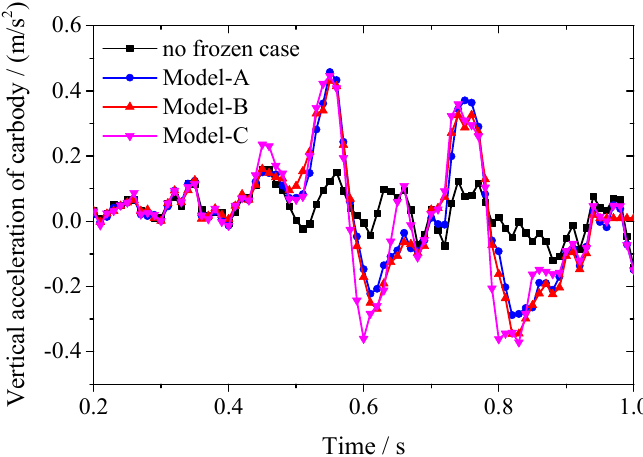
Figure 15. Time history of vertical acceleration of car body force with different models.